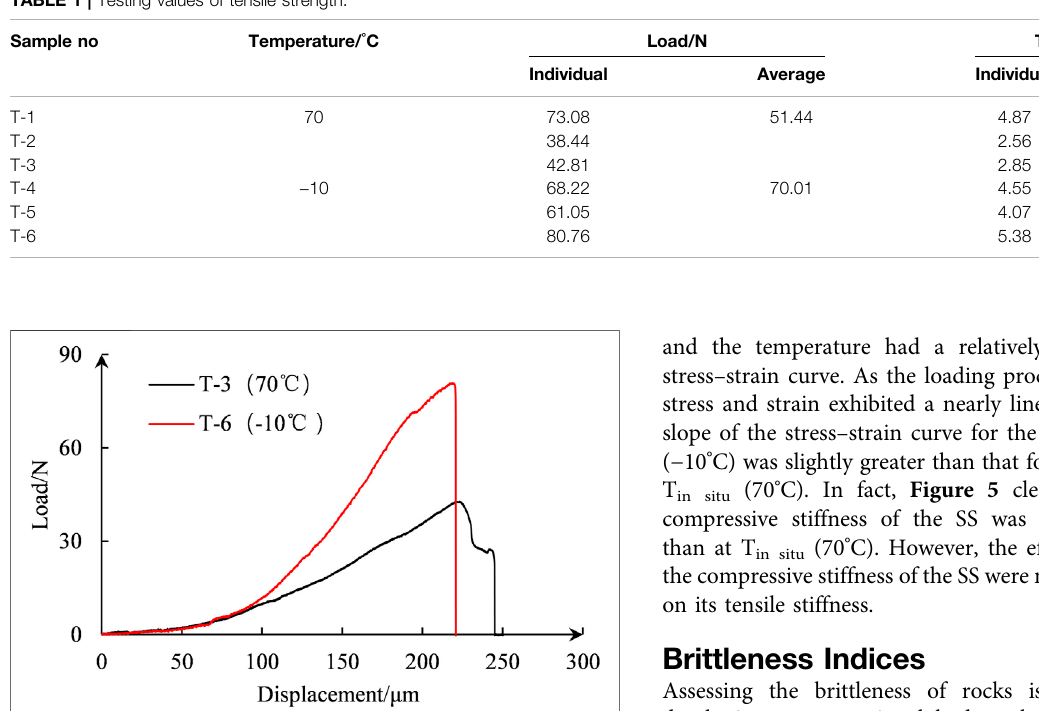
FIGURE 4 | Load – displacement curves from direct tension tests.